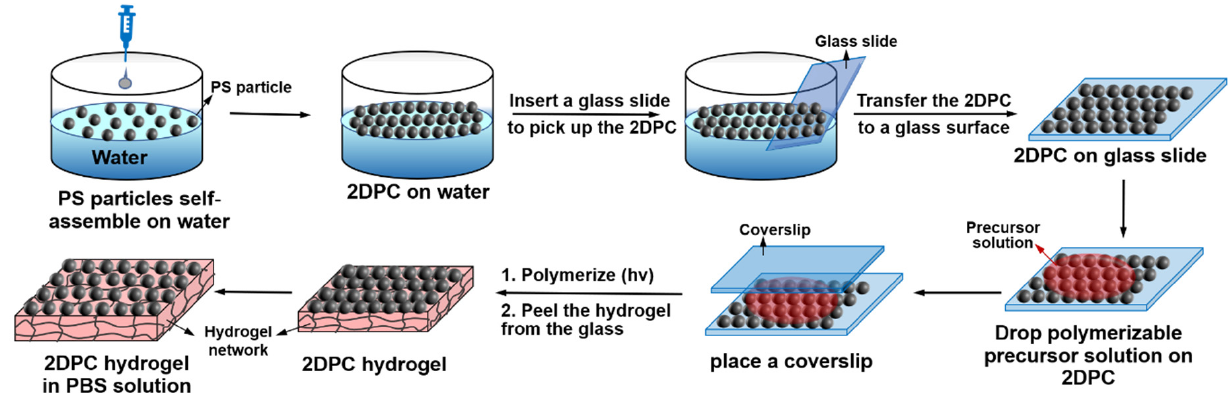
Figure 1. Fabrication of photonic hydrogels. PS particles were injected onto the water surface and orderly self-assembled to form a 2DPC array on water, followed by transfer to a glass slide. Then, polymerizable precursor solution was added to the 2DPC surface on glass substrate, and a coverslip was subsequently placed on the solution. The photopolymerization was performed and the 2DPC was embedded in the hydrogel network. The resultant 2DPC hydrogel was peeled off the glass slide and washed by water and PBS solution, and finally stored in PBS solution.